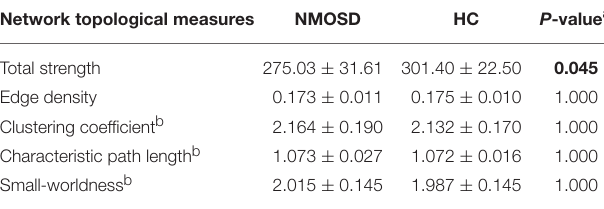
TABLE 3 | Global network topological